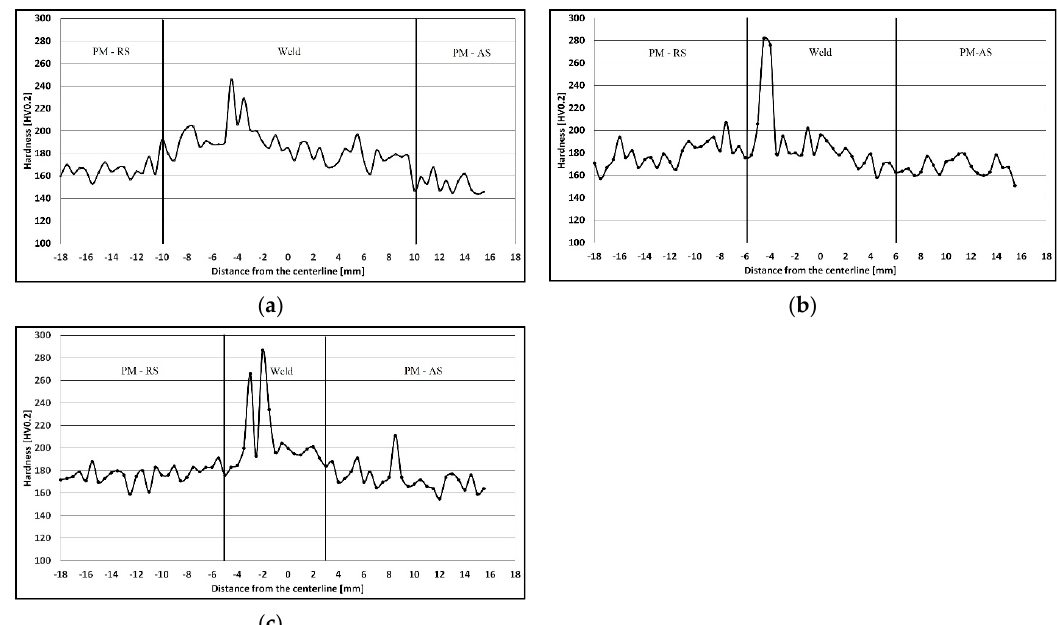
Figure 6. Microhardness profiles taken across the weld at various depths: ( a ) 0.8 mm; ( b ) 1.6 mm; ( c ) 2.4 mm.